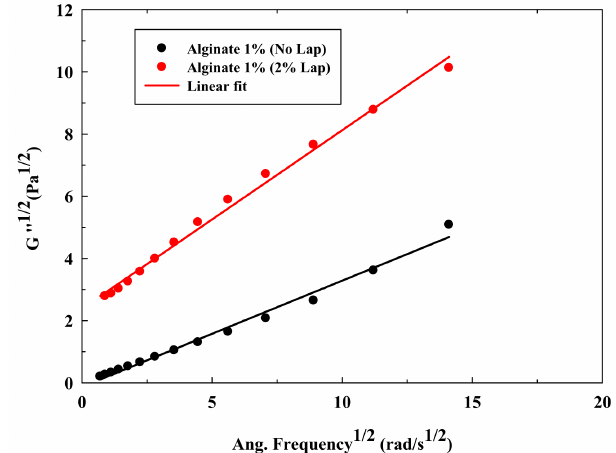
Figure 3. Modified Casson model for alginate solution (1.0% w / w ) and alginate solution (1.0% w / w ) with 2.0% w / w of Laponite ®